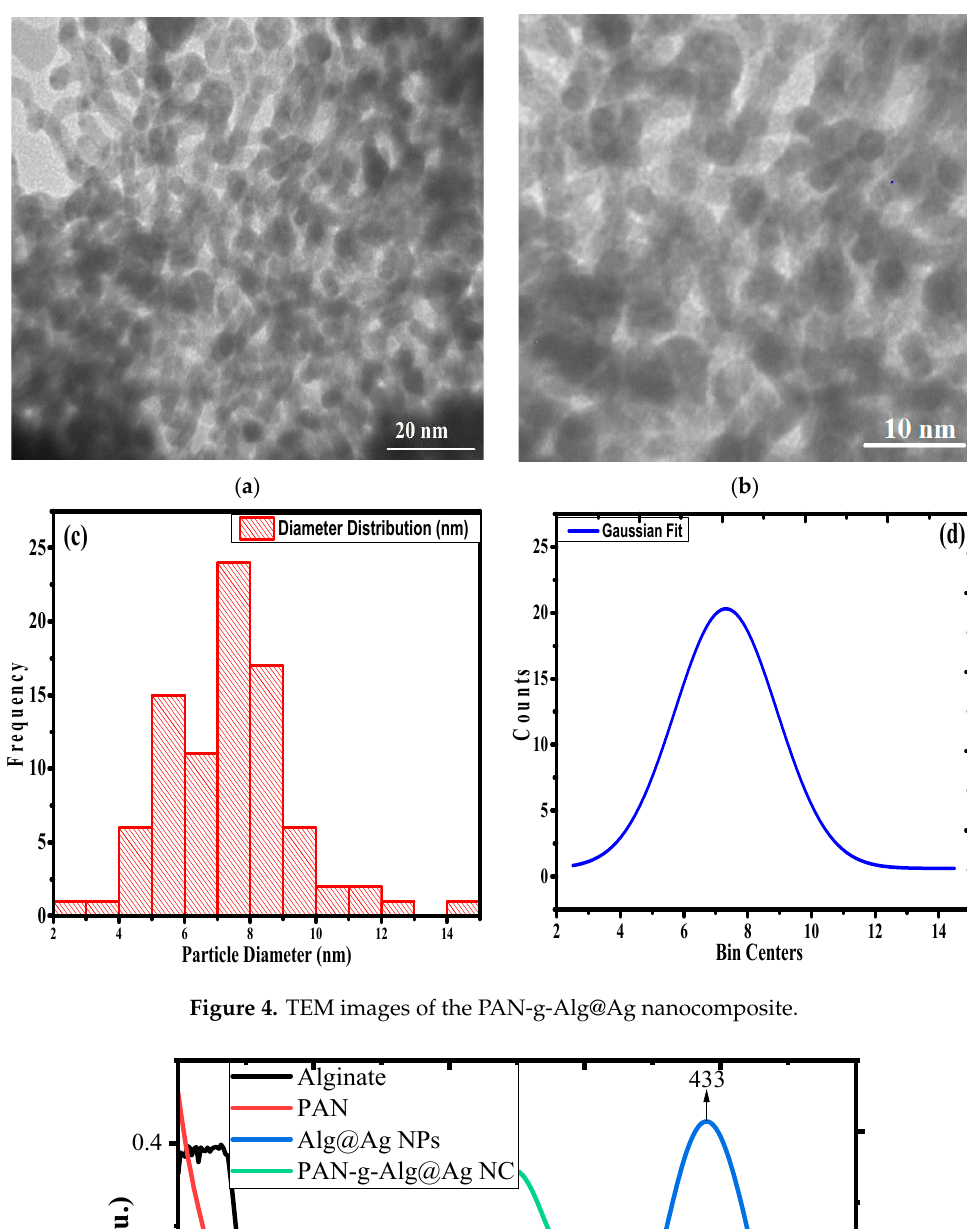
Figure 4. TEM images of the PAN-g-Alg@Ag nanocomposite.